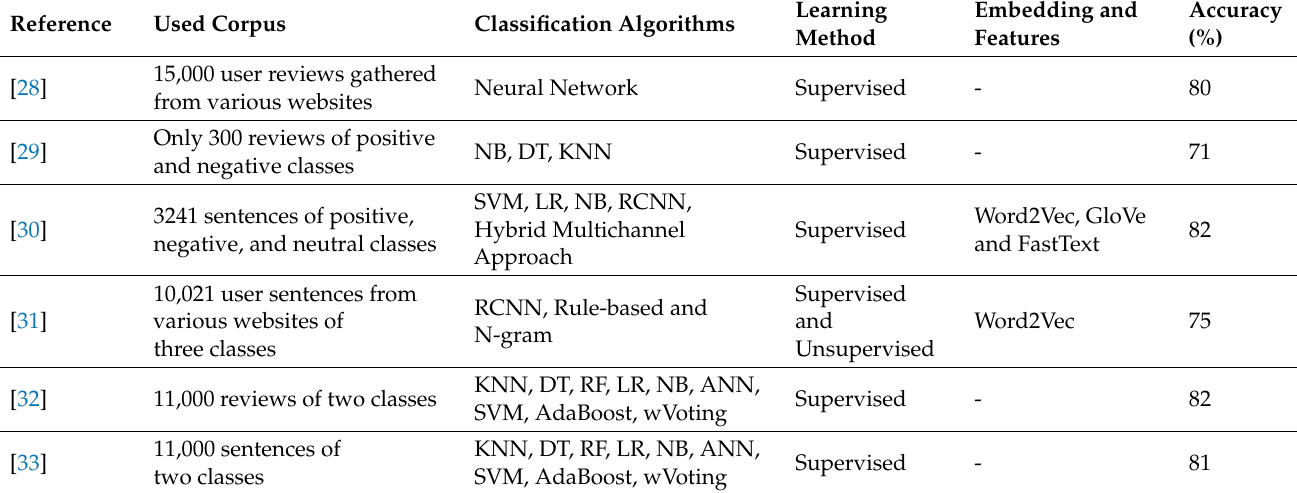
Table 1. Summary and comparison of existing